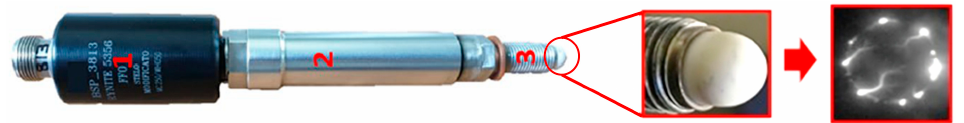
Figure 2. Tested igniter ( left ) (1 = inductor, 2 = connection, 3 = fi ring end) and corresponding fi ring end detail ( middle ). Discharge event ( right ): ionization waves (i.e., streamers) propagated above the igniter cupola.